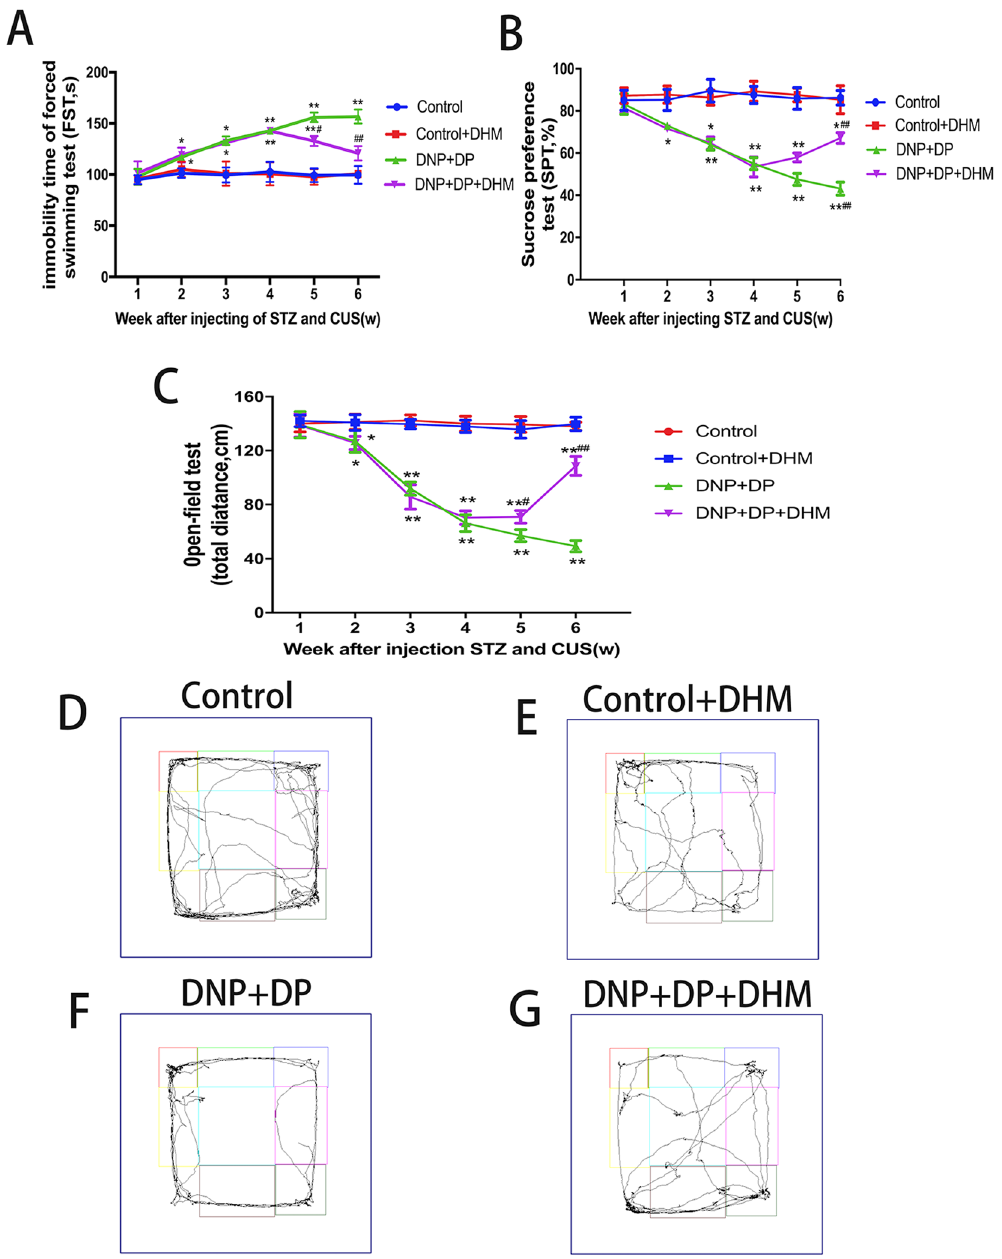
Figure 2. Effects of dihydromyricetin on the forced swimming test (FST) ( A ), sucrose preference test (SPT) ( B ) and open-field test (OFT) ( C ) in rats with comorbid DNP and DP. Figure D, E, F and G represented the total distance passed by the rat in each group recorded using a Canon camera model Powershot A610. Values are the mean ± SEM of 6 observations. * p < 0.05 and ** p < 0.01 vs . control group; # p < 0.05 and ## p < 0.01 vs . DNP + DP